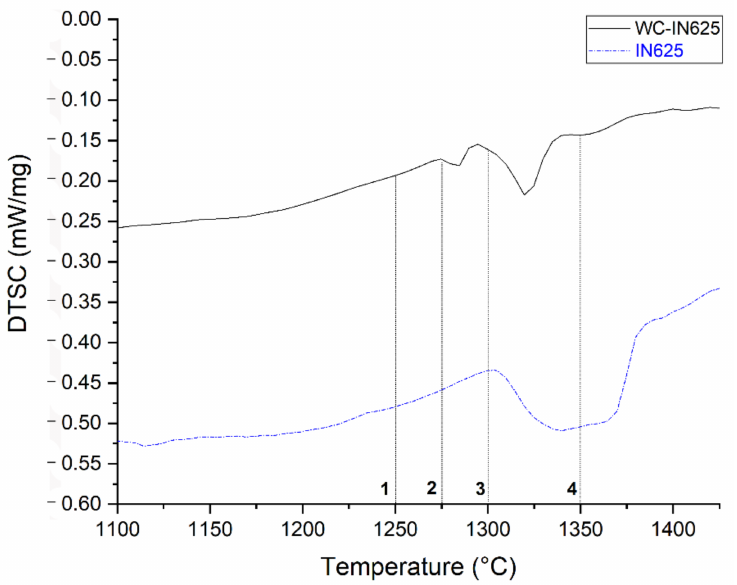
Figure 1. Differential Temperature Scanning Calorimeter (DTSC) curve of IN625 powder and of 70 wt.% WC–30 wt.% IN625 at a heating rate of 10 ◦